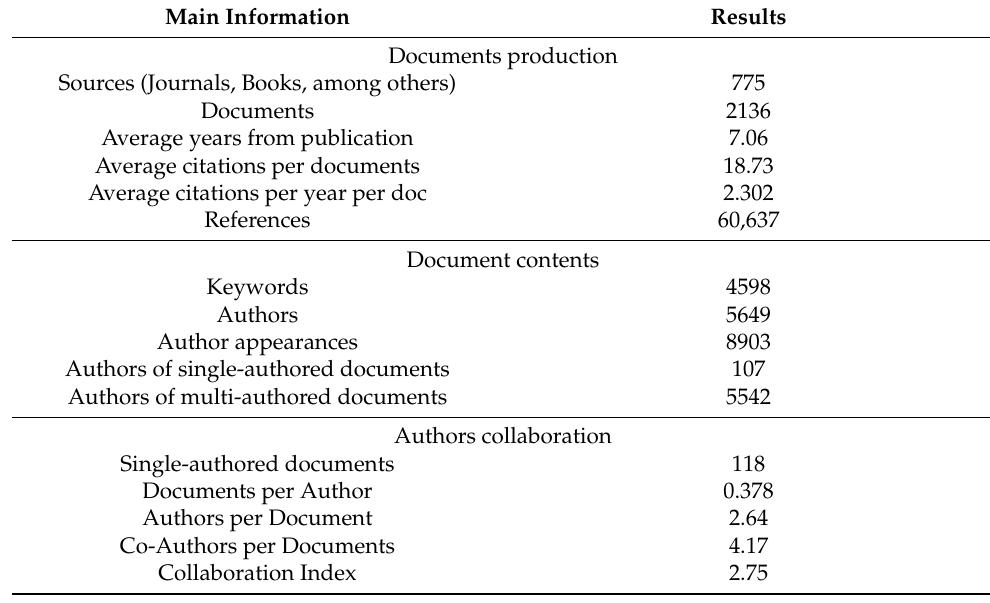
Table 4. Main data of the combined database.